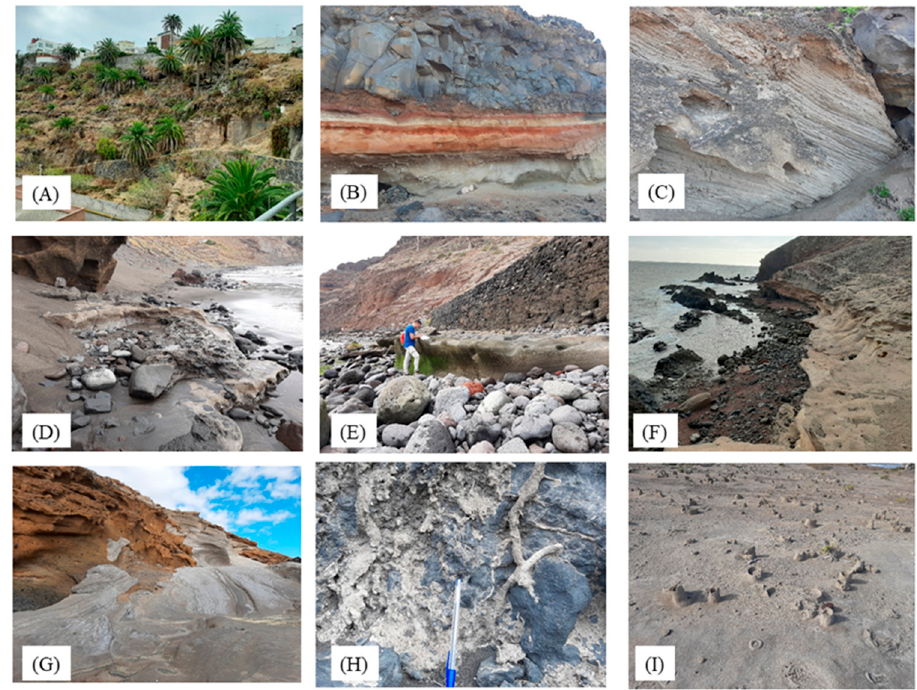
Figure 4. Palaeodunes of Tenerife. ( A ): Puerto de la Cruz; ( B ): Jóver; ( C ): Milán; ( D ): Antequera; ( E ): Igueste de San Andrés; ( F ): El Médano; ( G ): Montaña Amarilla; ( H ): rhizolithes in Antequera; ( I ): palaeoliquefaction structures in El Médano-Montaña Roja. Source: authors.